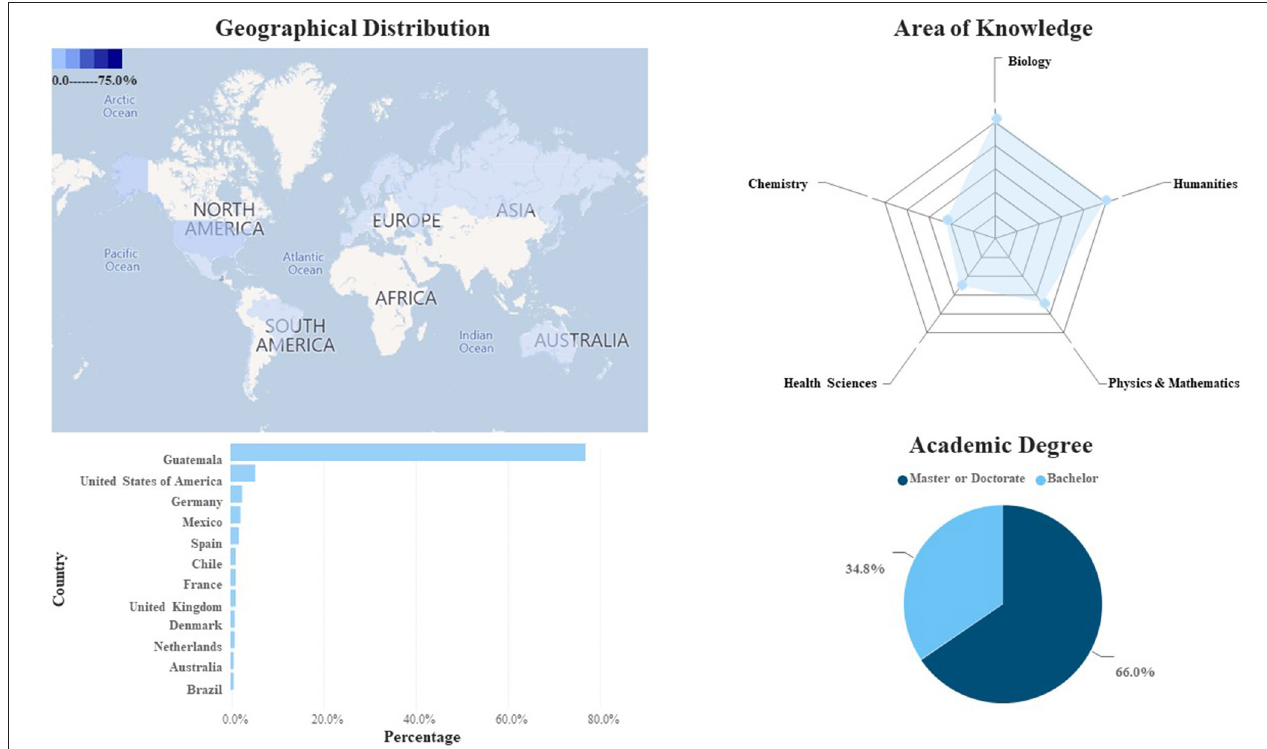
FIGURE 3 | Geographical distribution, area of knowledge, gender, and academic degree distribution of members of the Guatemala National Chapter of the Organization of Women in Science for the Developing World OWSD (February